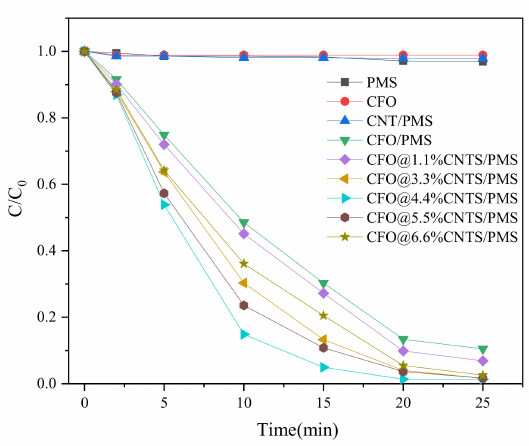
Figure 7. Degradation of CQP in different systems. (Experimental conditions: [[CQP] 0 = 10 mg/L, catalyst = 35 mg/L, PMS = 2.0 mM, initial pH = 6.5 ± 0.3, T = 25 ◦